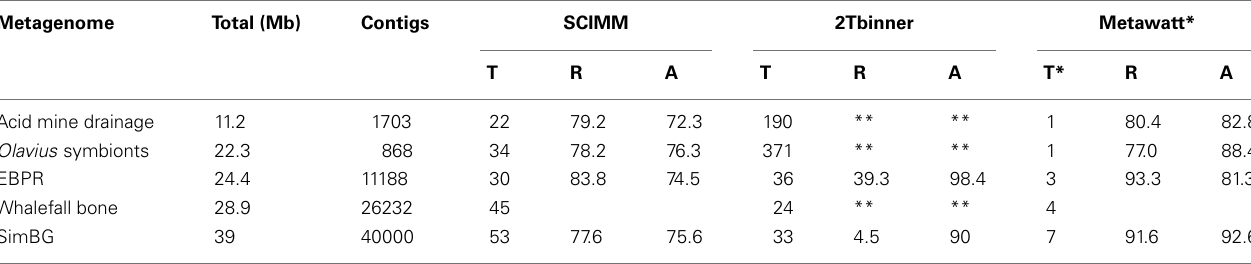
Table 1 | Performance (time,T, minutes, recall, R, percentage, accuracy,A, percentage) of the presented binning approach (Metawatt) for five publicly available metagenomes in comparison to two published two-step compositional binners: SCIMM (Kelley and Salzberg, 2010) and 2Tbinner (Saeed et al.,